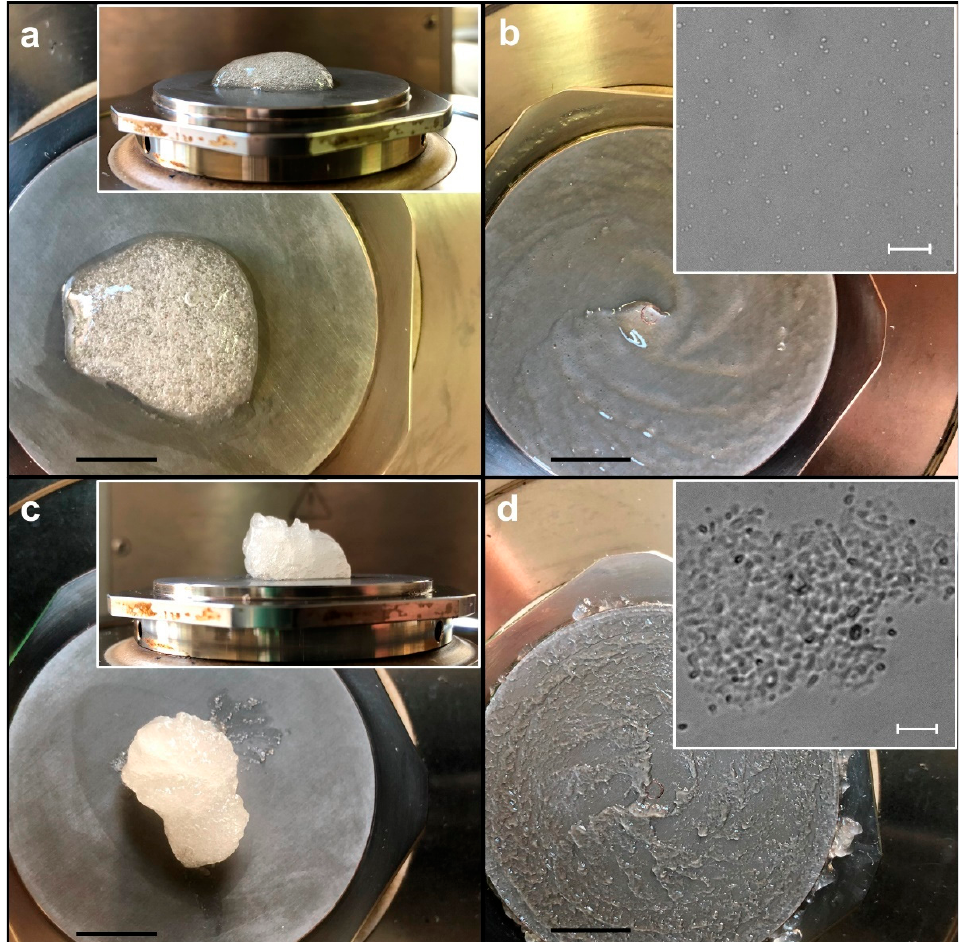
Figure 2. Top view of substrate beads on the rheometer bottom plate. Substrate with 3% w/v HEC before ( a ) and after ( b ) experiment; substrate with 5% w/v HEC and 1.6% w / v guar gum before ( c ) and after ( d ) experiment (the black scale bars are 10 mm). In ( a , c ), the insets are side-views of the substrate bead in the respective images. In ( b , d ), the insets show E. coli cells after the experiment in the respective substrate sample; images were taken with an optical microscope (white scale bars are 10 µm). The spatial distribution of cells agrees with Atis et al. [32] and Dufrêne and Persat [39], i.e., colonies are more compact when the substrate is highly viscous.